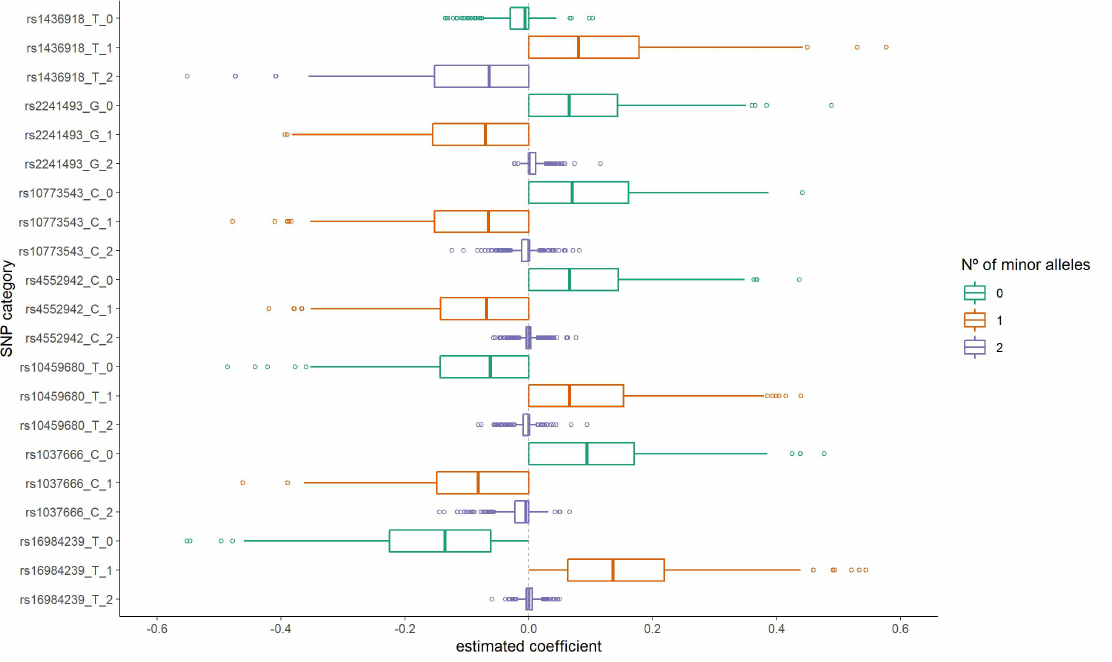
Figure 2. Distribution of the estimated coefficients for the seven most frequently selected variants in the first step group LASSO